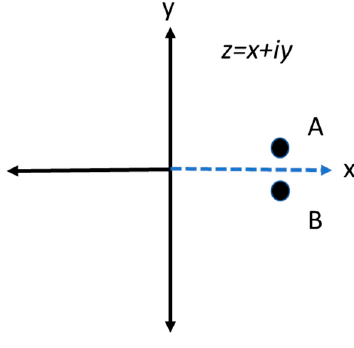
Figure A2. Representation of branch cut at positive x-axis showing discontinuity across two points A and B.